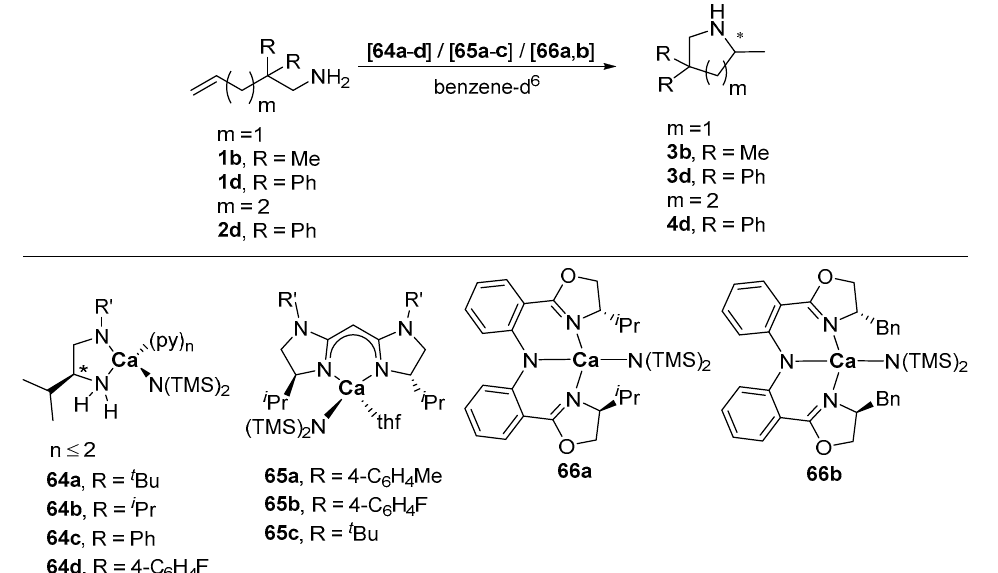
Scheme 9. Catalytic asymmetric intramolecular hydroamination of aminoalkenes 1b , d and 2d using data see Table 17). Table 17. Catalytic asymmetric intermolecular hydroamination of aminoalkenes 1b , d and 2d using the chiral calcium catalysts 64a – d , 65a – c and 66a , b a .